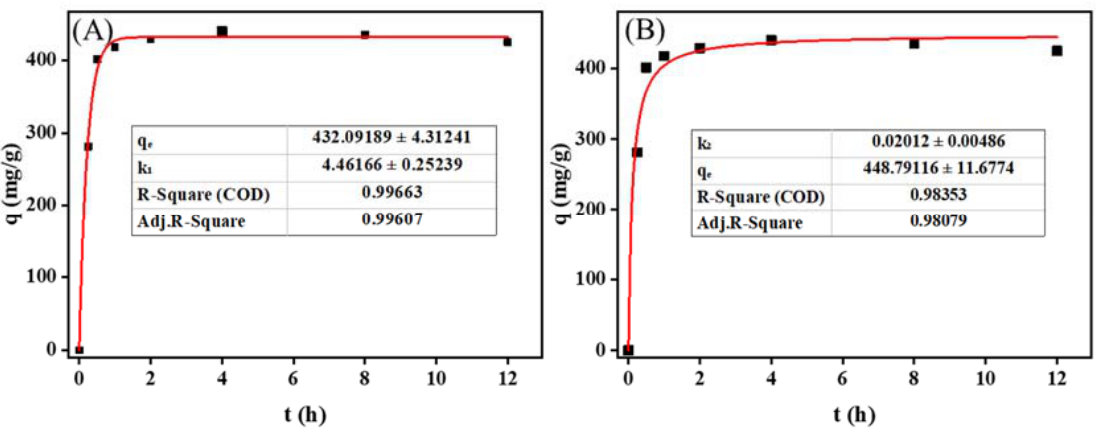
Figure 4. Adsorption kinetic model fitting results of menthol on MIL ‐ 101 (Cr): ( A ) pseudo ‐ first ‐ order kinetic model; ( B ) pseudo ‐ second ‐ order kinetic model.